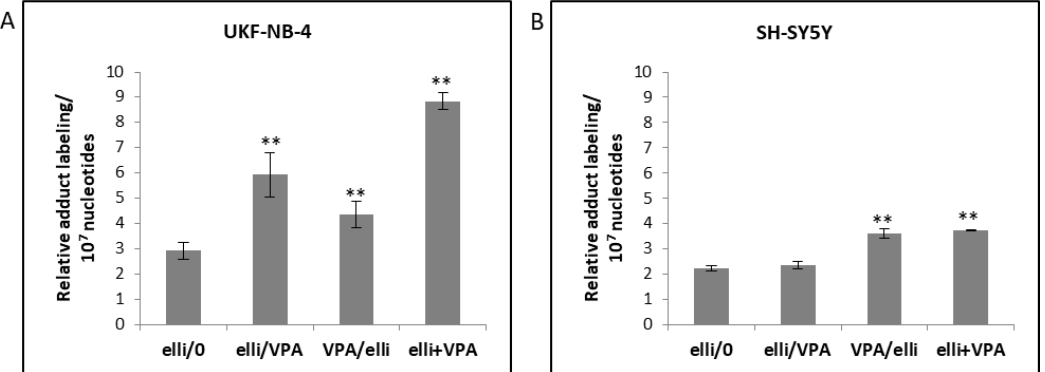
Figure 11. Total levels of ellipticine-derived DNA adducts formed in UKF-NB-4 ( A ) and SH-SY5Y ( B ) cells after treatment with 5 µM ellipticine (elli) and with this drug combined with 1 mM valproic acid (VPA) determined by 32 P-postlabeling. Experimental treatment conditions are described in Table 1. Relative adduct labeling is expressed as adducts per 10 7 normal nucleotides. Values represent mean ± SD from three independent experiments. ** p < 0.01 as compared to elli/0 group (ANOVA with post-hoc Tukey HSD Test). Table 2. DNA adduct formation by ellipticine in neuroblastoma UKF-NB-4 and SH-SY5Y cell lines treated with ellipticine and this drug combined with VPA. Experimental treatment conditions are described in Table 1.